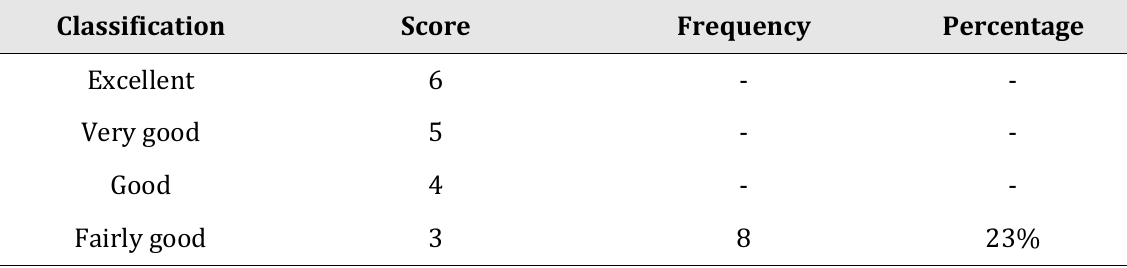
Table 10. Rate Percentage Point of Learners’ Comprehensibility in Pre -test Result